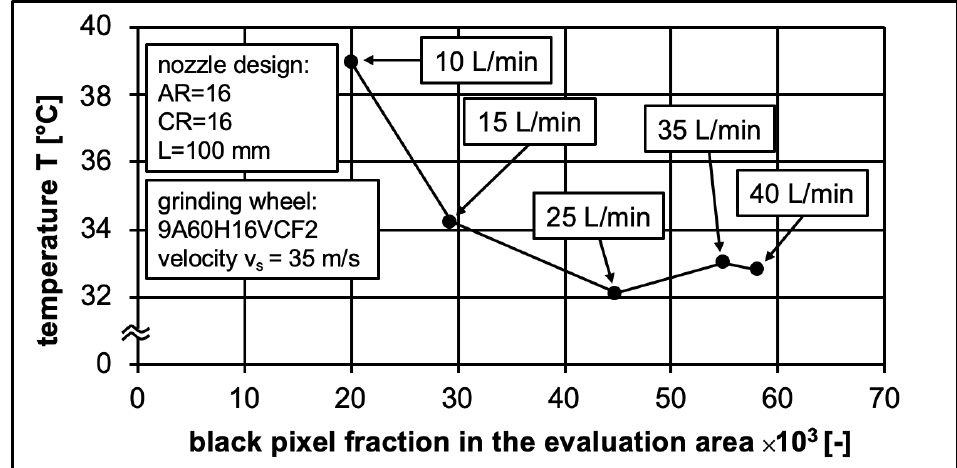
Figure 17. Course of the temperature over the black pixel fraction by different flow rates.